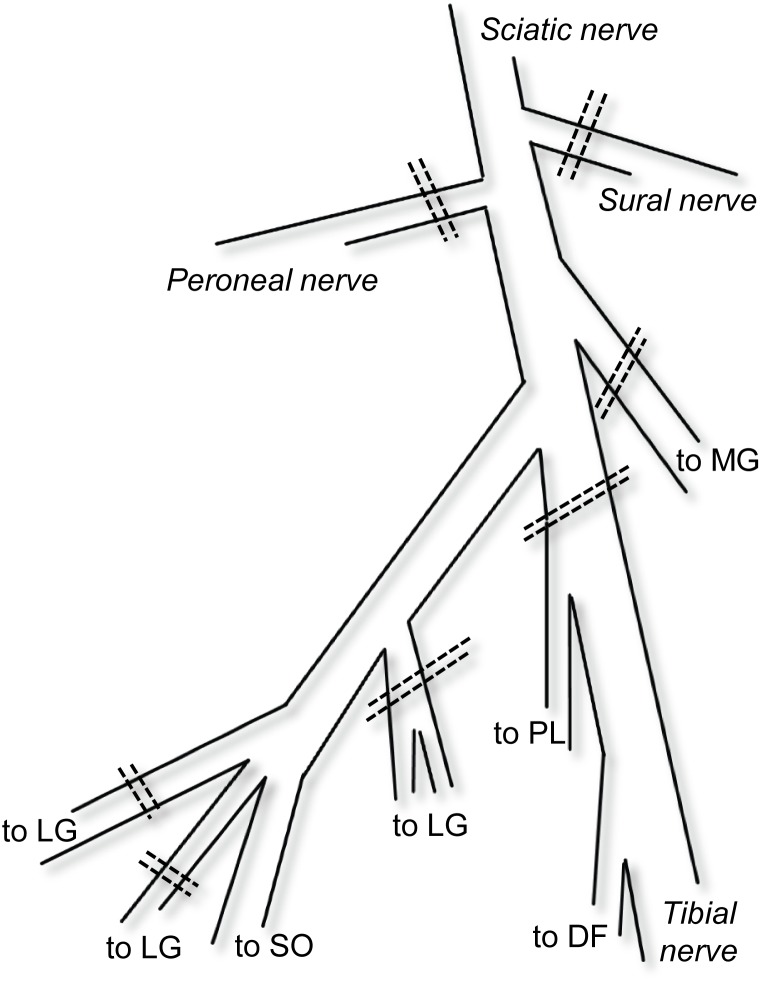
Schematic view of branches of the sciatic nerve in the popliteal fossa.To excite only SO muscle fibers, a cuff electrode was applied onto the sciatic nerve and several nerve branches were transected. Dashed lines represent transection of nerves. MG: medial gastrocnemius. LG: lateral gastrocnemius. SO: soleus. PL: plantaris. DF: deep flexor muscles.